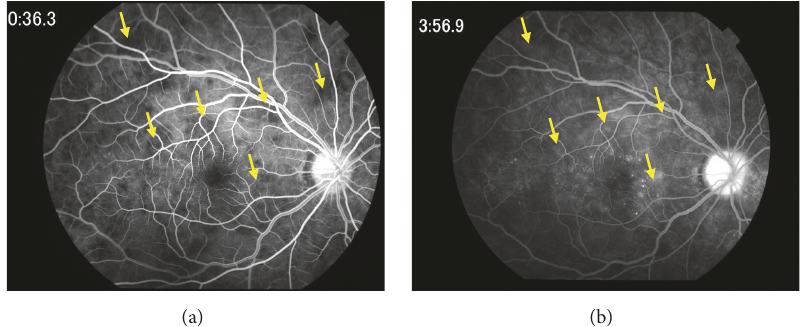
Figure 3: Fluorescein angiography of the right eye at presentation. (a) Early-phase fluorescein angiogram shows areas of hypofluorescence corresponding to the placoid lesions. (b) Late-phase fluorescein angiogram shows the conversion of hypofluorescence to hyperfluorescence (arrows).